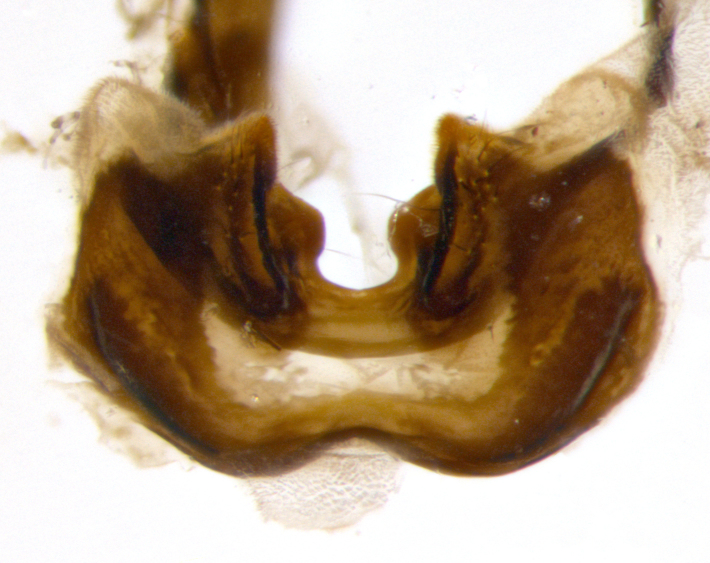
sternite 5, ventral view